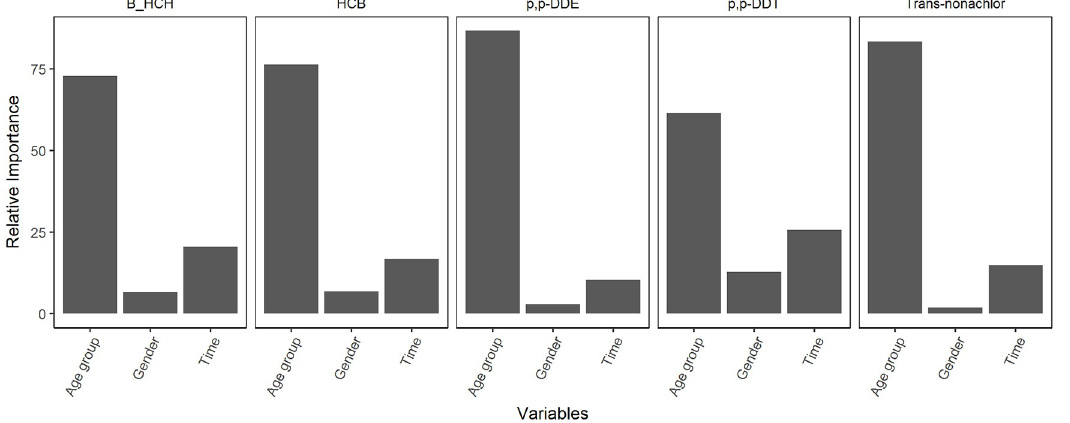
Fig 2. Graphical summary of relative importance of variables in BRT models. Relative importance of variables in predicting the concentrations of β -HCH, HCB, p,p’ -DDE, p,p’ -DDT and Trans-nonachlor based on a BRT analysis. In order of relative importance (left to right), the variables are age group, time and